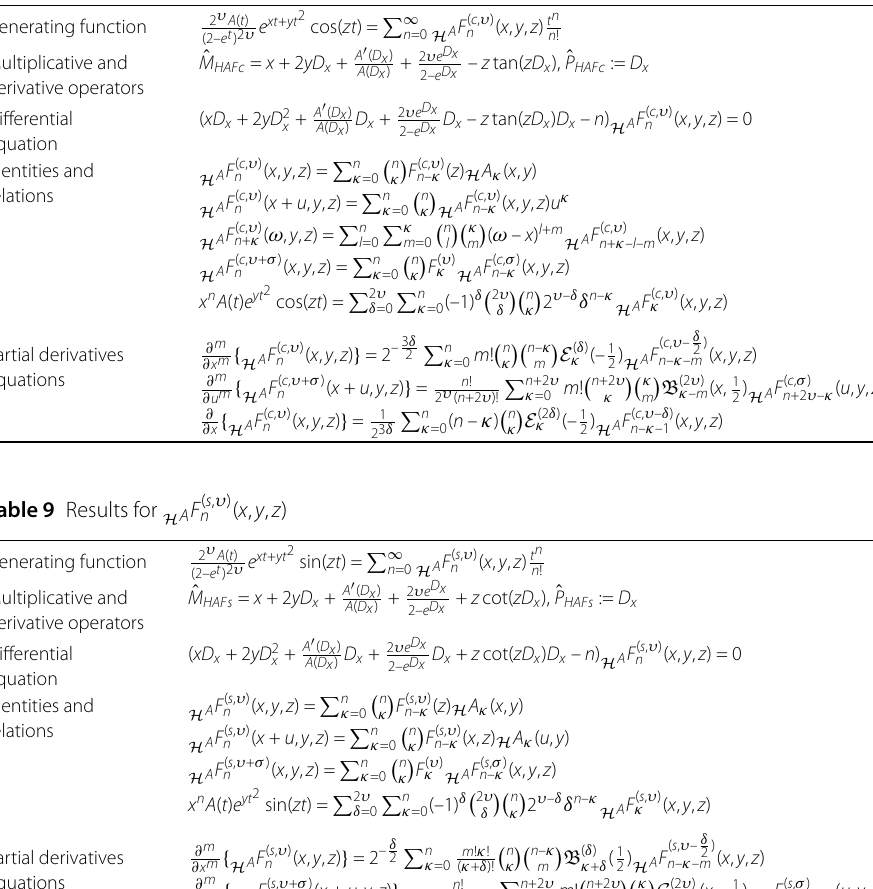
F ( c , υ ) n ( x , y , z ) H A